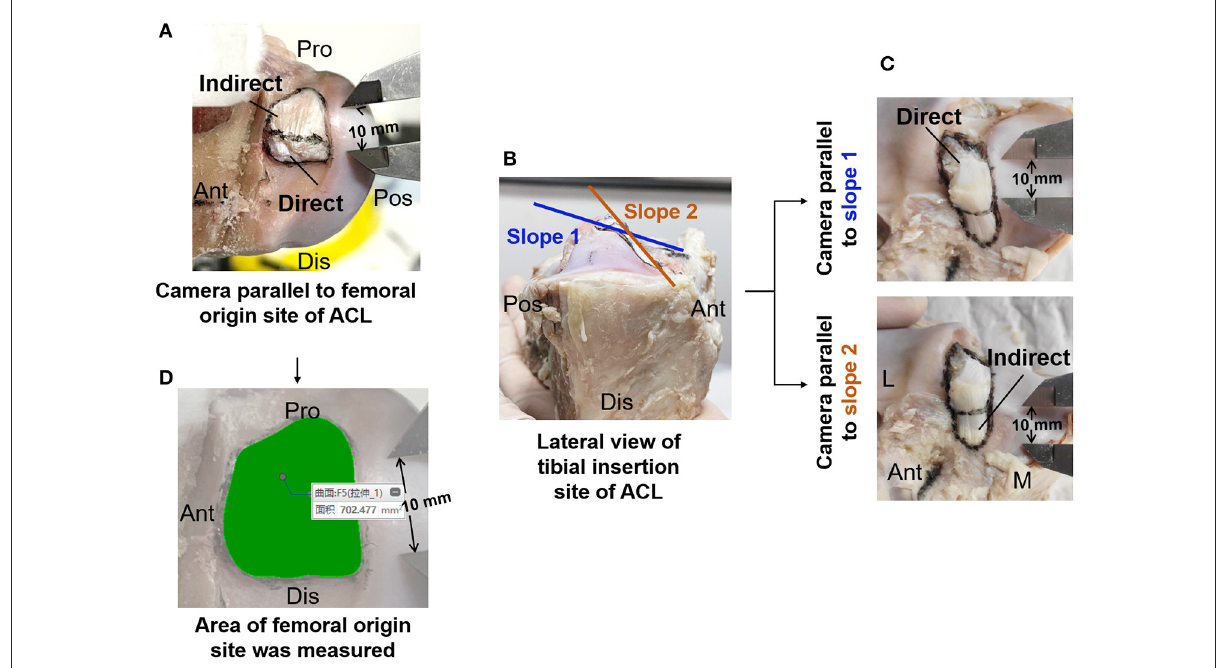
FIGURE3 Measurement of insertion site of ACL. (A) Image of femoral origin site of ACL divided into direct and indirect part. (B) Double-sloped tibial insertion site of ACL with the slopes shown parallel to the direct and indirect part. (C) Image of tibial insertion site of ACL. (D) Area of